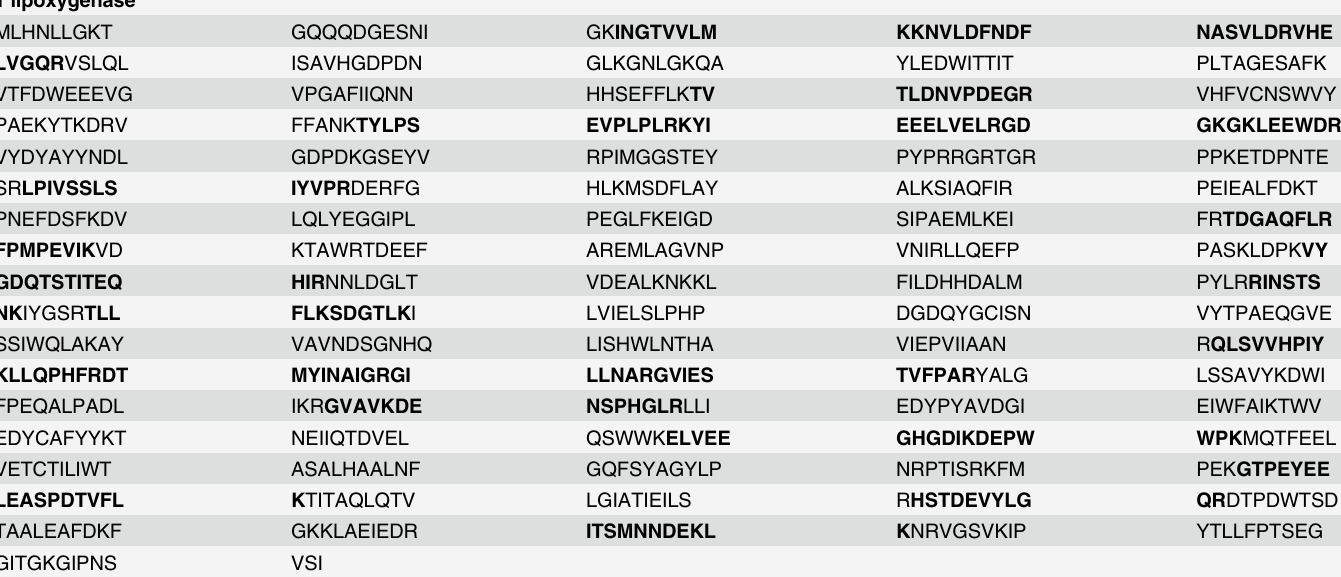
As presented in Fig 3A and Fig 4, acumulation levels of lipoxygenase (LOX, band 1), β -galacto- sidase ( β -GAL, band 2), NADP-malic enzyme (NADP-ME, band 3), Dehydrin COR47 (band 4) and ferritin-4 (band 11) increased during the incubation, and were remarkably reduced by CHA-treatment. Meanwhile, levels of thaumatin-like protein (TLP, band 9) and 5'-3' exoribo- nuclease 2 (band 10) were enhanced by CHA-treatment.